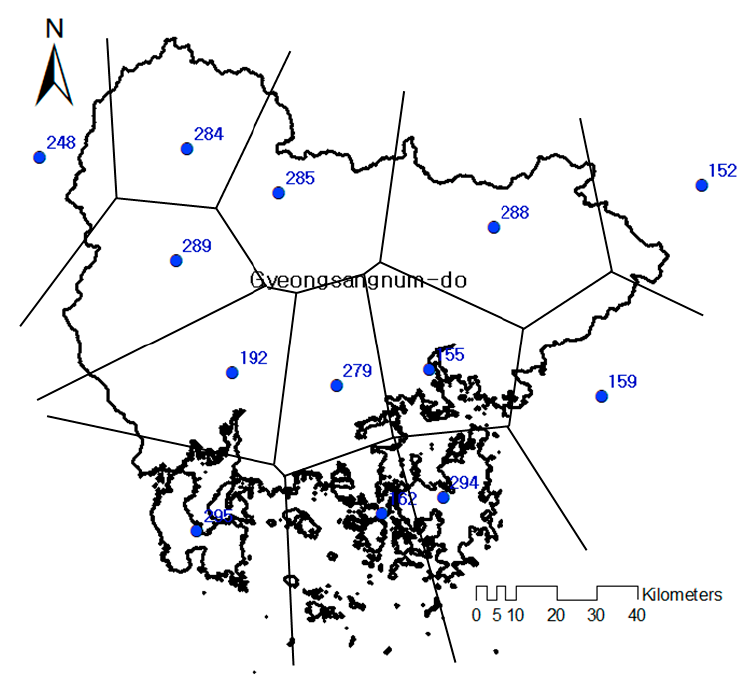
Figure 6. Thiessen polygon distribution for Gyeongsangnamdo. The rainfall stations for Gyeongsangnamdo were analyzed starting from January 1973, but the observation dates for Changwon (no. 155) and Geochang (no. 284) started in January 1988. As the observation dates were different, the area ratio of a Thiessen polygon was calculated as the weight for 11 stations before 1988 and 13 stations after 1988. Table 4 lists the weights of rainfall stations according to the analysis period. The Changwon (no. 155) and Geochang (no. 284) stations represented approximately 20% of the total weight, and the weights after 1988 were reduced by 0.6 to 3.8% compared to those before